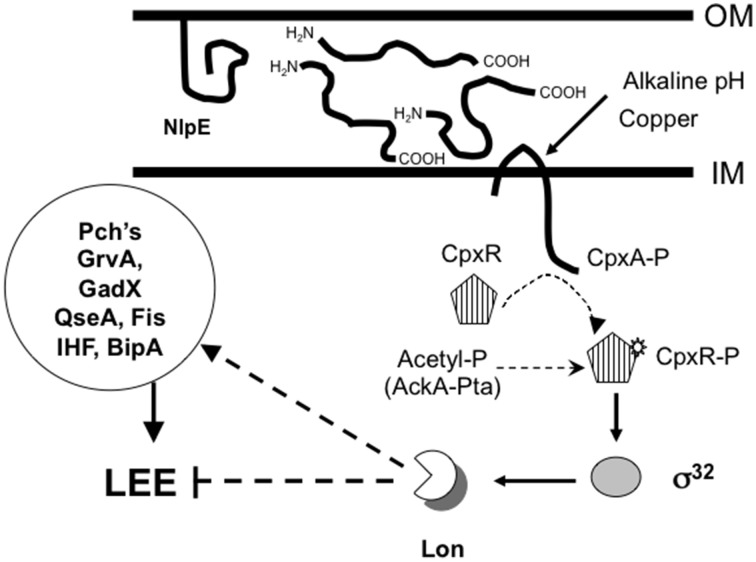
CpxA-CpxR-RpoH-Lon-LEE complex regulatory cascade. Current model about the LEE regulation initiated by the CpxRA. CpxA senses a variety of stimulus (pH changes, copper, overexpression of envelope proteins such as NlpE or P pilus subunits, and alterations in membrane) within the bacterial cell envelope (Danese et al., 1995; Nakayama and Watanabe, 1995; Snyder et al., 1995; Jones et al., 1997; Danese and Silhavy, 1998; Hung et al., 2001; Yamamoto and Ishihama, 2005). rpoH P1 promoter (Sigma 32 factor) is activated by CpxR (Figure 5A, Zahrl et al., 2006) and RpoH activates lon promoter (Zhao et al., 2005; Nonaka et al., 2006). Lon negatively regulates LEE expression probably affecting stability of Ler and/or GrlA proteins (Figure 5).